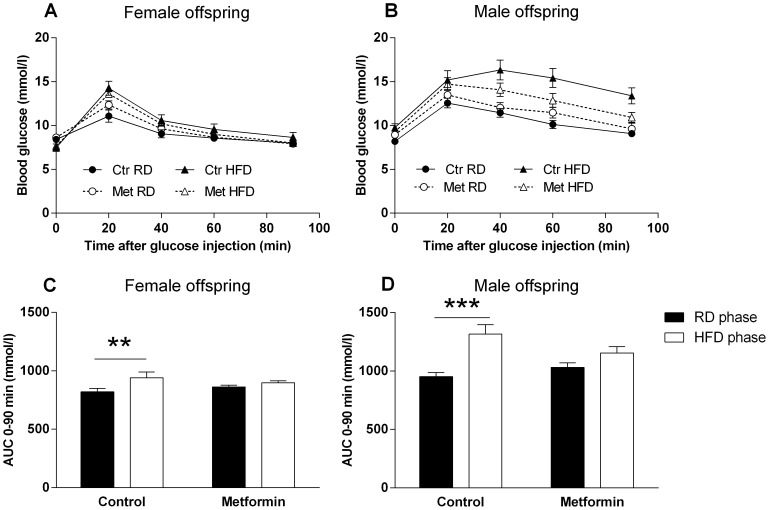
Glucose tolerance of the offspring during RD and HFD.GTT of the female (A) and male offspring (B) at 10 weeks of age during RD and after 5–6 weeks of HFD. Black circles (•)  =  Control offspring on RD, open circles (○)  =  Metformin offspring on RD, Black triangles (▴)  =  Control offspring on HFD, open triangles (Δ)  =  Metformin offspring on HFD. n = 12–16. AUC values of the GTT of the female (C) and male (D) offspring. ** = P<0.01 and *** = P<0.001 by 2-way RM-ANOVA and Sidak's multiple comparisons test. P-value of interaction 0.063 in C and <0.05 in D.